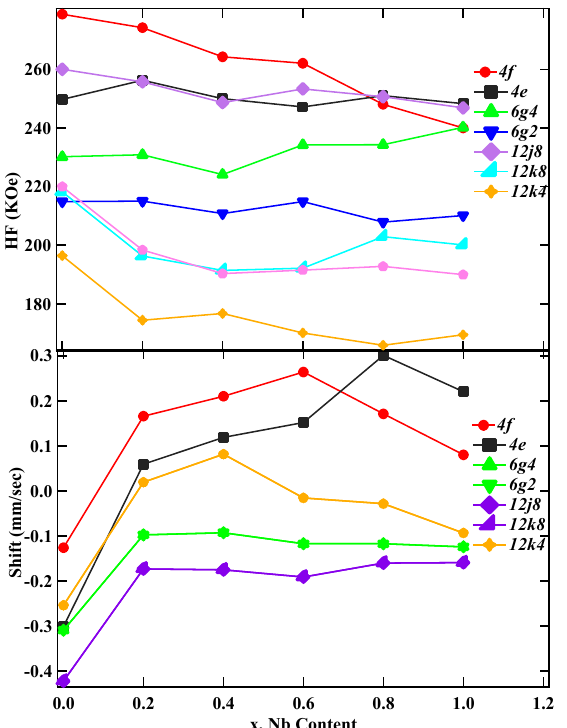
Figure 7. RT Mössbauer hyperfine parameters and isomer shift plots as a function of x , Nb con- tent.